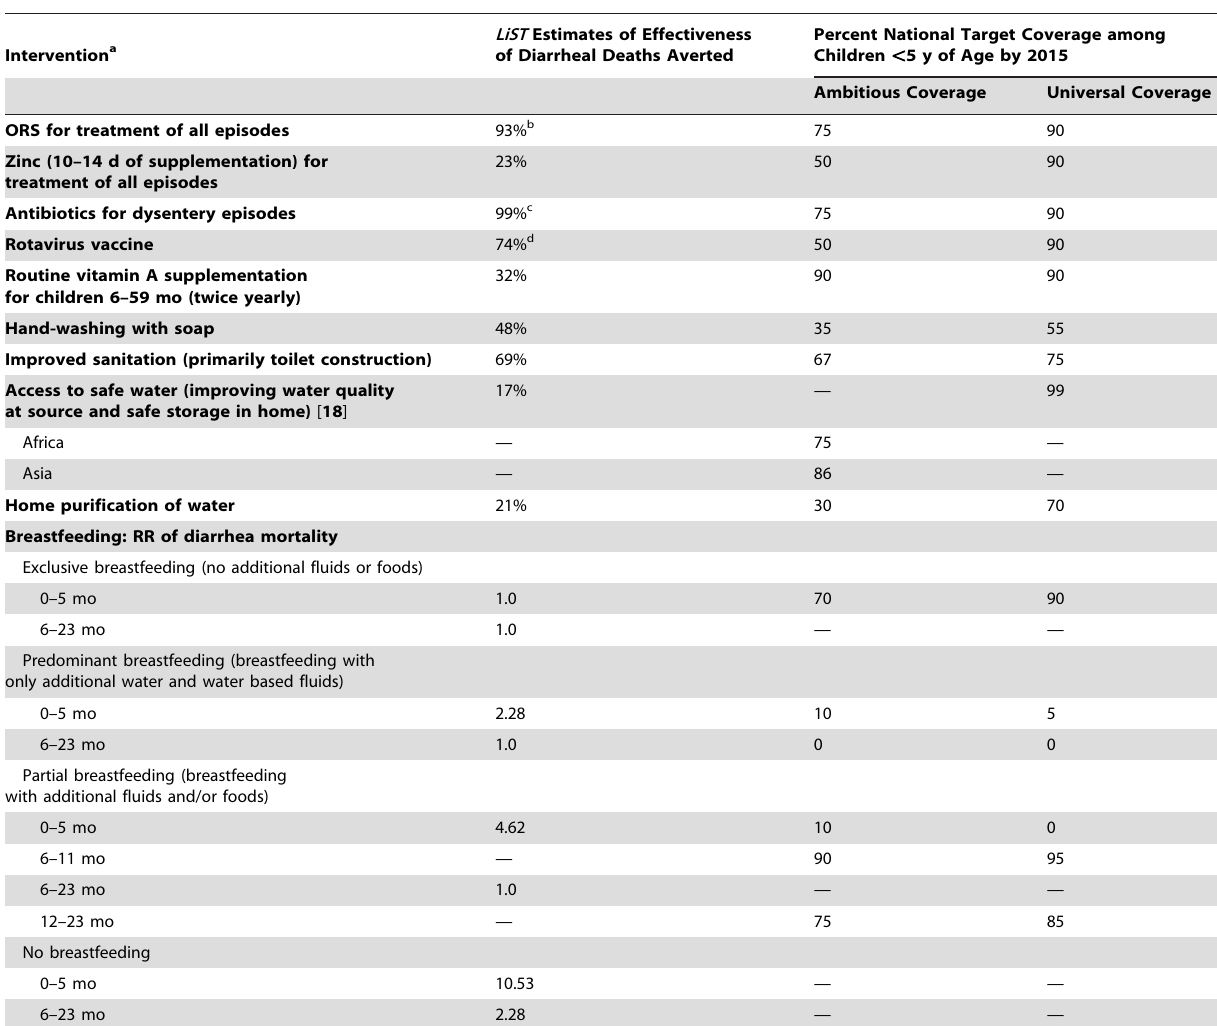
Table 2. Modeled target coverage rates by intervention for two scale-up plans for the 68 priority countries.